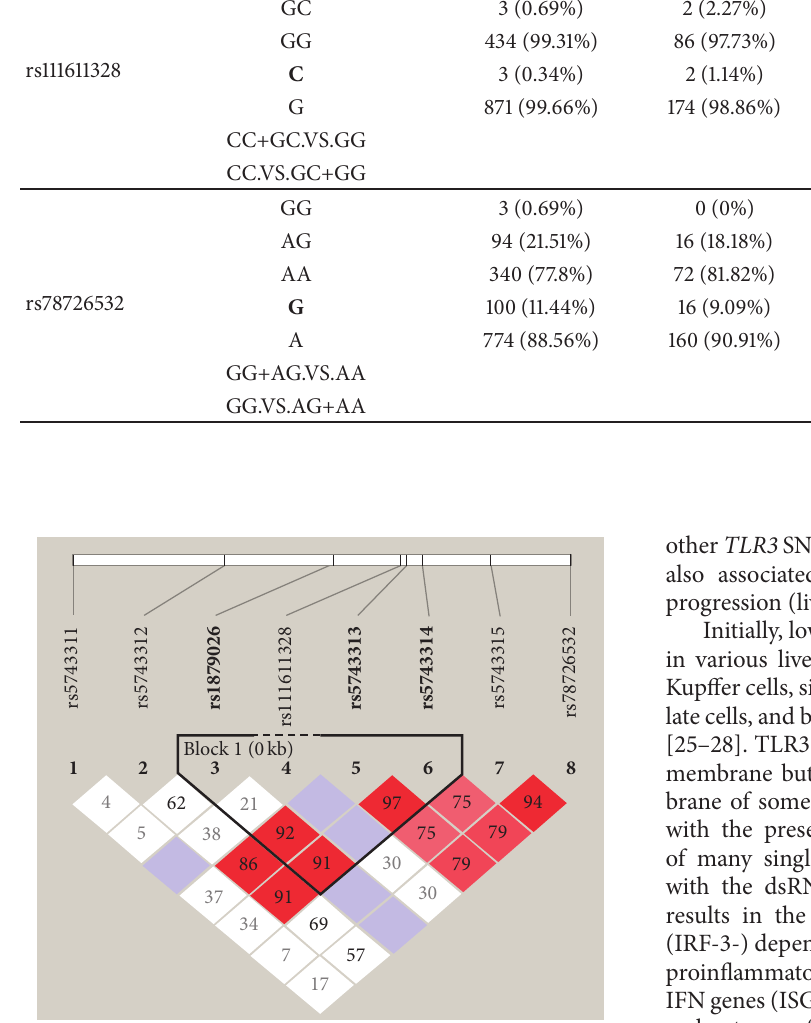
Figure 1: LD plot of SNPs in the TLR3 gene region. The plot was generated by Haploview 4.2. Numbers in squares show LD between the